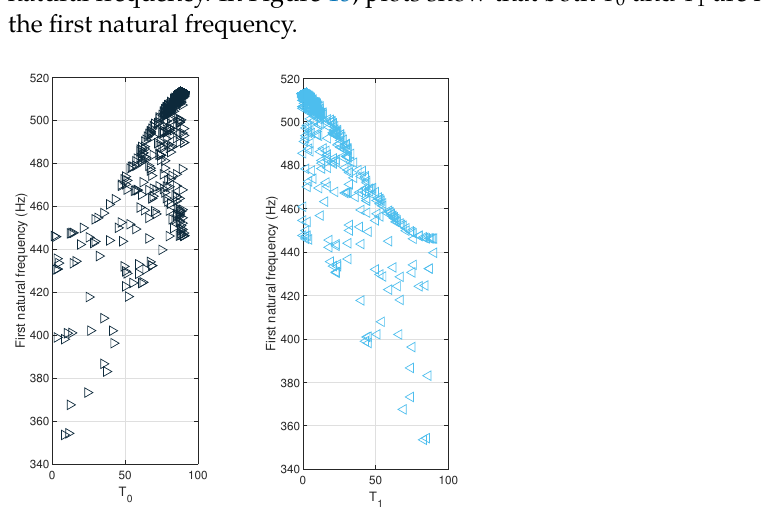
Figure 15. Distribution of variables and first natural frequency; first natural frequency— T 0 , first natural frequency— T 1